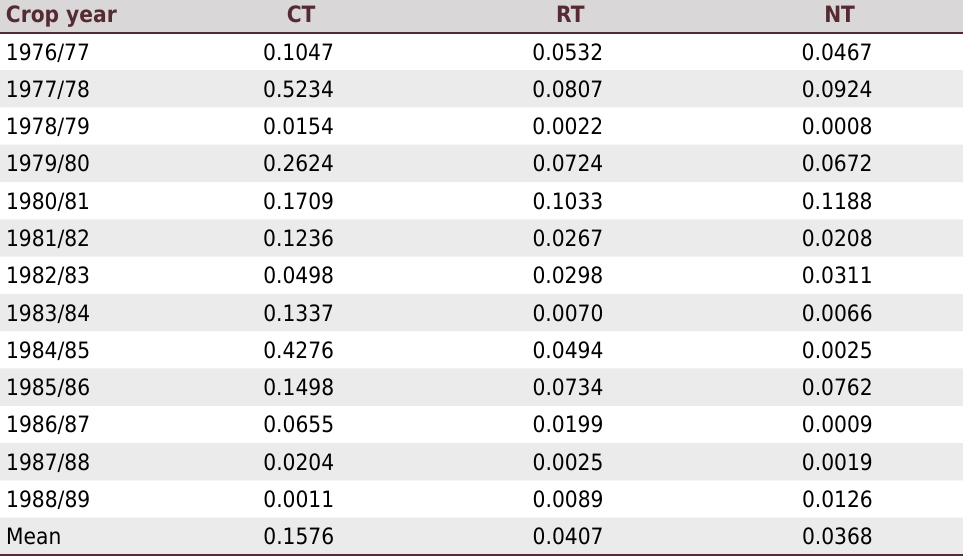
Table 3. Annual mean C factor during the 13-year evaluation of the